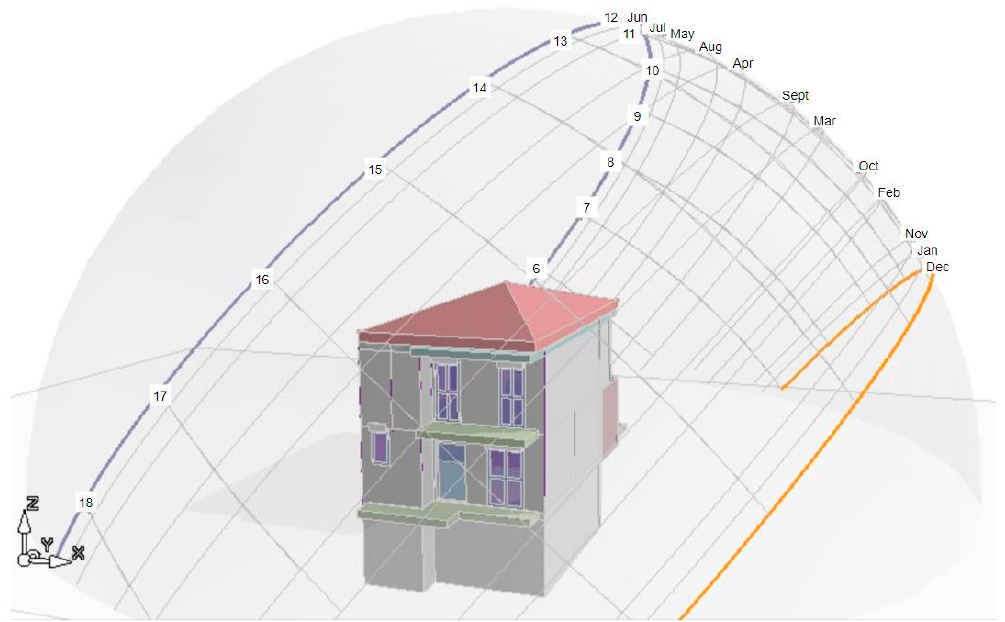
Figure 5. The multi-storey building used for numerical simulation and related solar